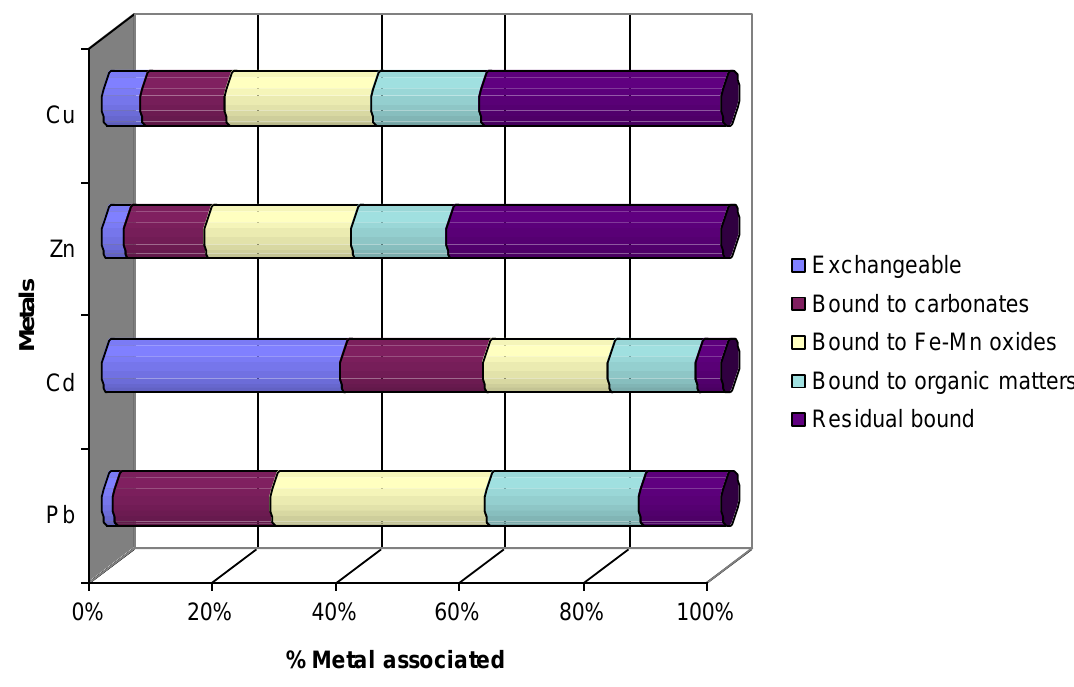
FIGURE 1. Association of metals with different fractions of soils of the study